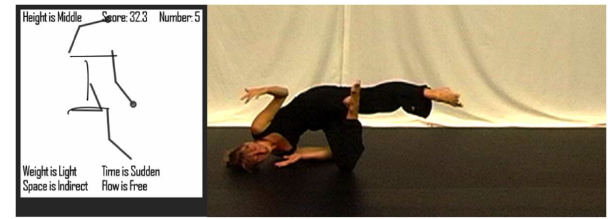
Figure 3. Scuddle’s Movement